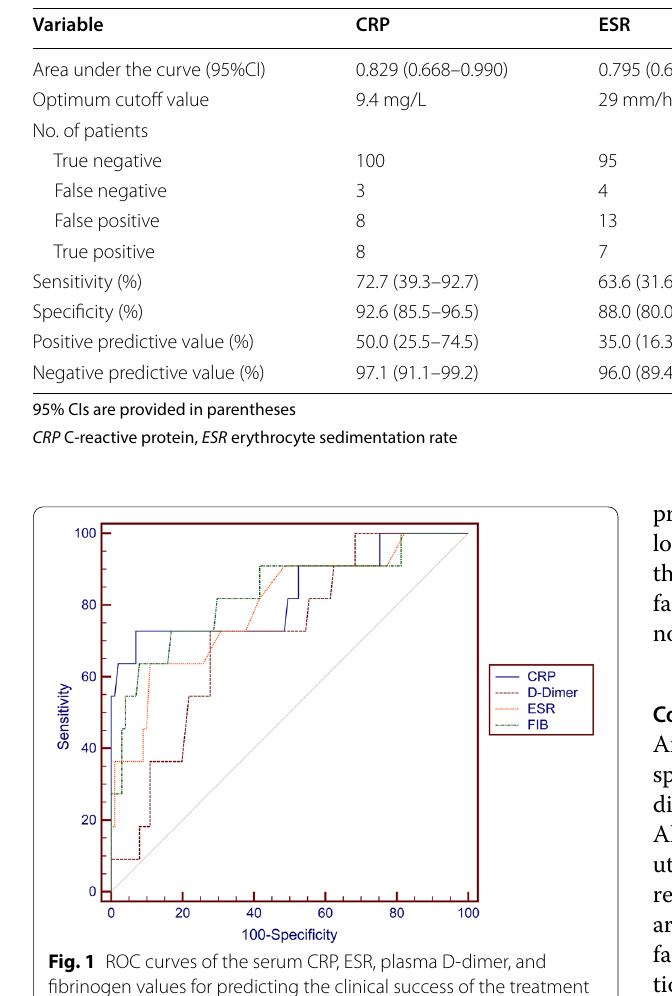
Table 3 Summary of results